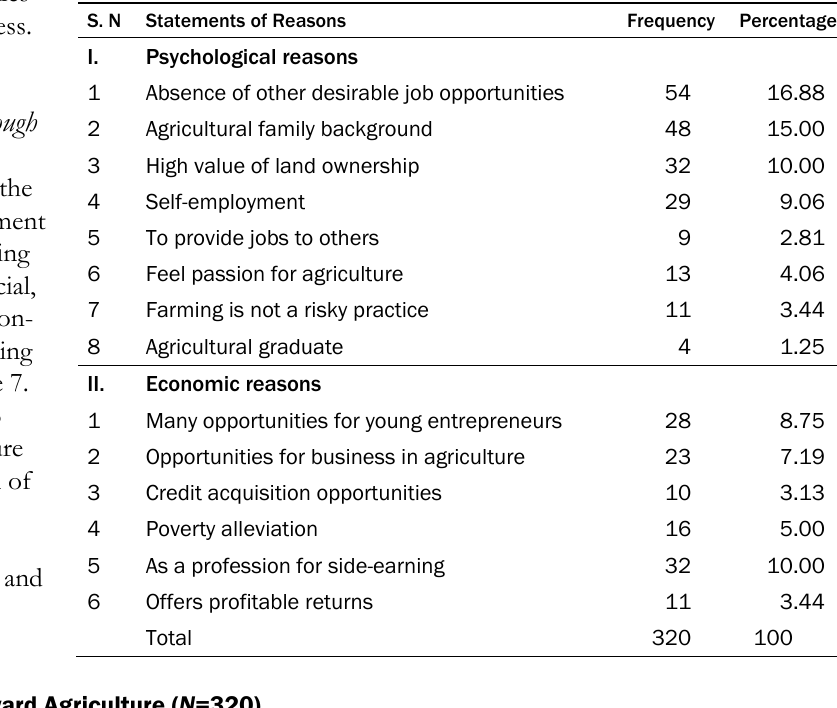
Table 6. Factors that Attract Youth to